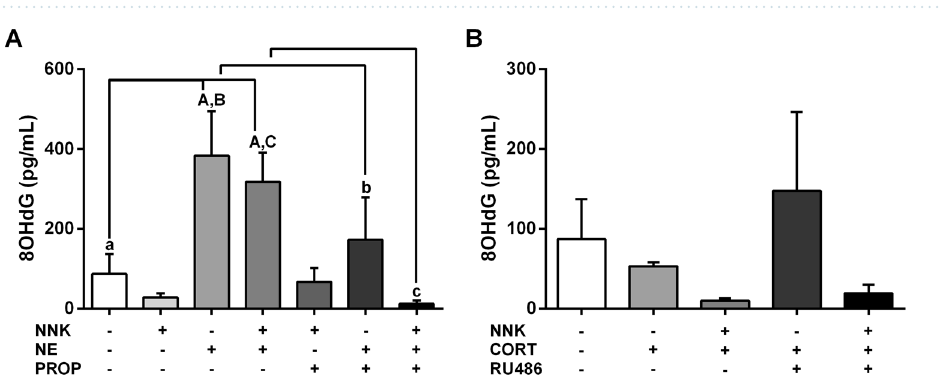
Figure 6. Effects of stress hormones on oxidative DNA damage in oral epithelial cells. ( A ) Norepinephrine up-regulated the 8OHdG levels in the presence or absence of carcinogen NNK. Beta-blocker propranolol inhibited the increased oxidative DNA damage caused by the hormone combined to NNK. ( B ) Cortisol did not change the 8OHdG levels secreted by the NOK-SI cells. The results are expressed as the mean ± standard deviation (SD). Upper- and lower cases equal letters indicate a statistically significant difference ( p < 0.05). NNK = 4 (N-metil-N-nitrosamine)-1-(3-piridil)-butano-1-one). NE = norepinefrina. PRO p = propranolol. CORT = cortisol. NNK, NE, PROP and RU486 were used at 10 µM. CORT was used at 100 nM. NOK-SI cells were exposed to NNK and/or stress hormones in the presence or absence of their antagonists for 72